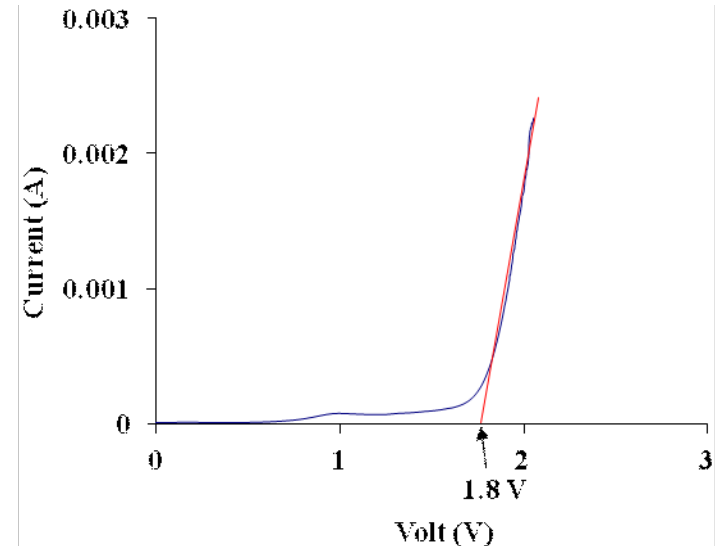
Figure 6. Linear sweep voltammetry curve for the film of PEMA-NH 35 wt %